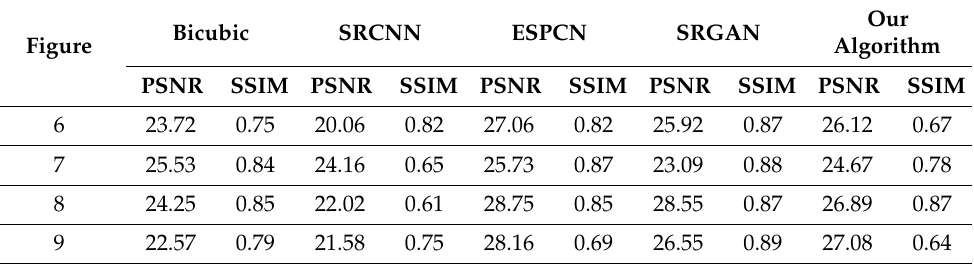
Table 2. Comparison of typical image experiment